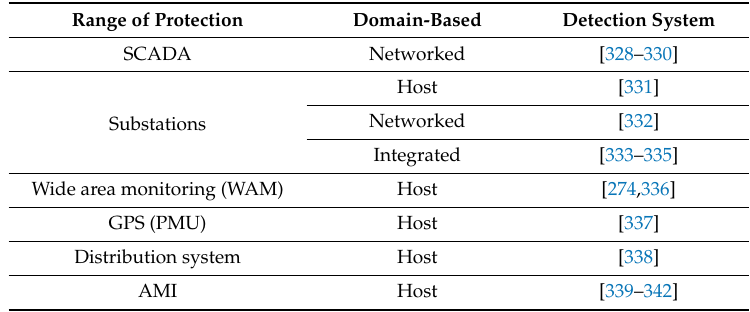
Table 10. Detection techniques in smart grids